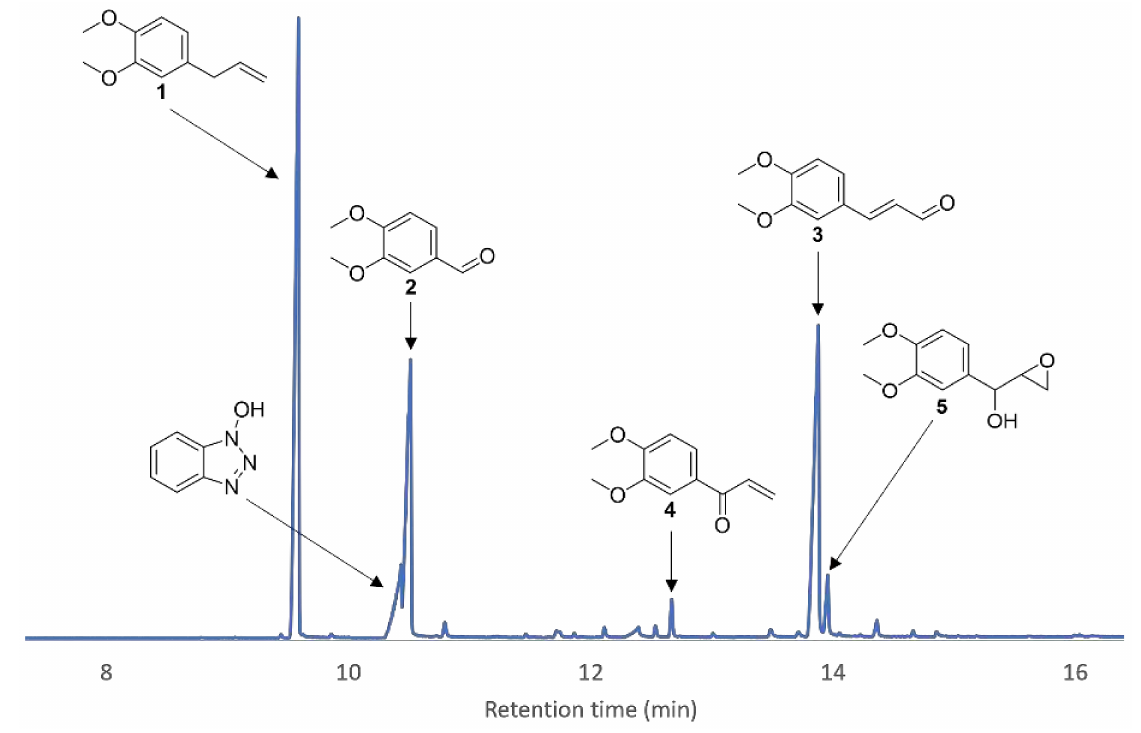
Figure 12. Zoom-in of a GC/MS chromatogram of the crude product after the enzymatic reaction of 1 with HOBt as a mediator. Five peaks were identified as oxidation products besides HOBt.